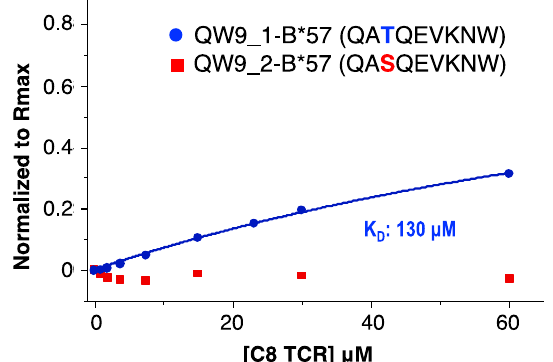
Figure 4. SPR binding affinity measurements for C8-LZ with QW9_1-B*57 and QW9_2-B*57. C8 TCR flowed through QW9_1-B*57 and QW9_2-B*57 coated chips (Series S sensor SA). (Blue curve repre- sents QW9_1-B*57, KD: 130 μ M; Red dots represent QW9_2-B*57, no detectable signaling).